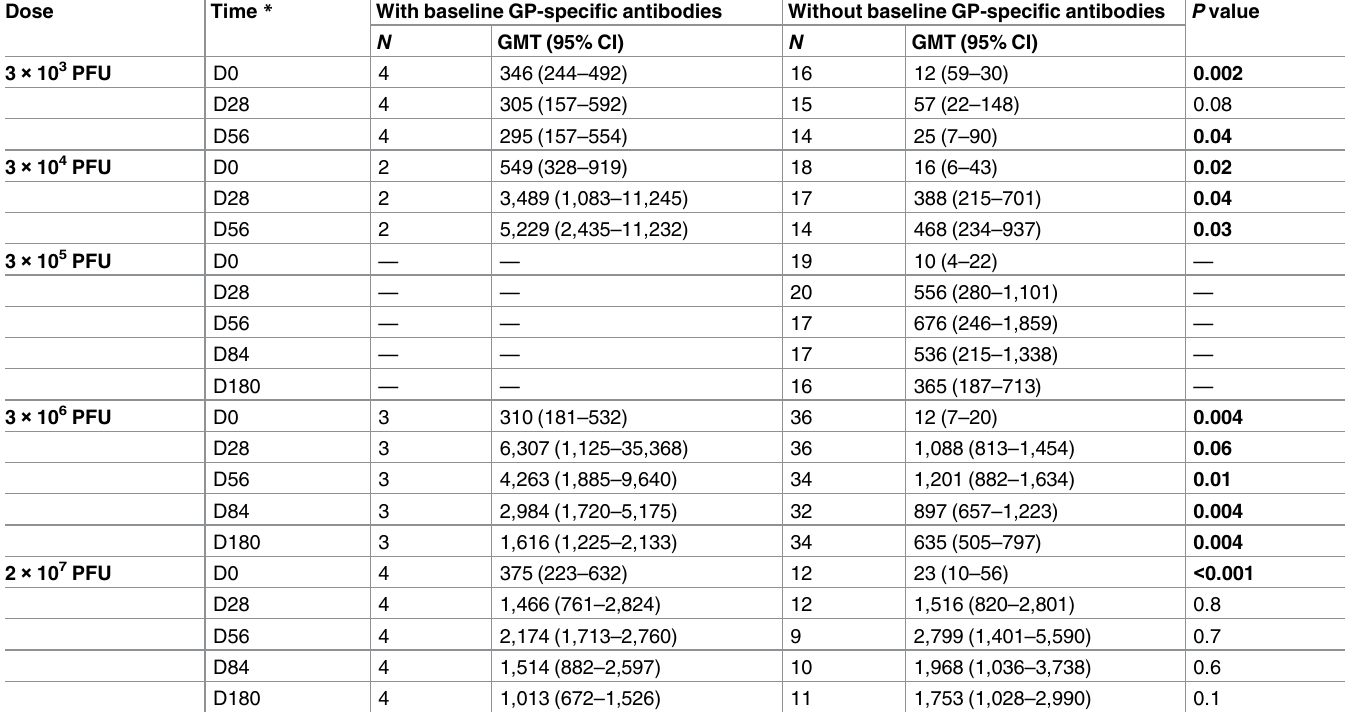
Table 4. Endpoint geometric mean titres measuredby USAMRIID ZEBOV-GP ELISA in adults with and without baseline specific antibodies. Dose Time * With baseline GP-specific antibodies Without baseline GP-specific